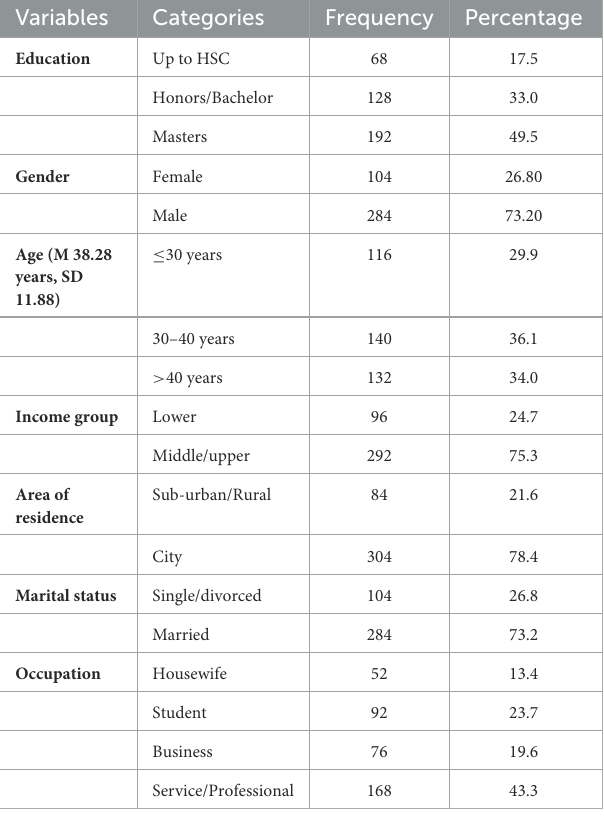
TABLE 1 Sociodemographic characteristics of study participants ( N = 388).